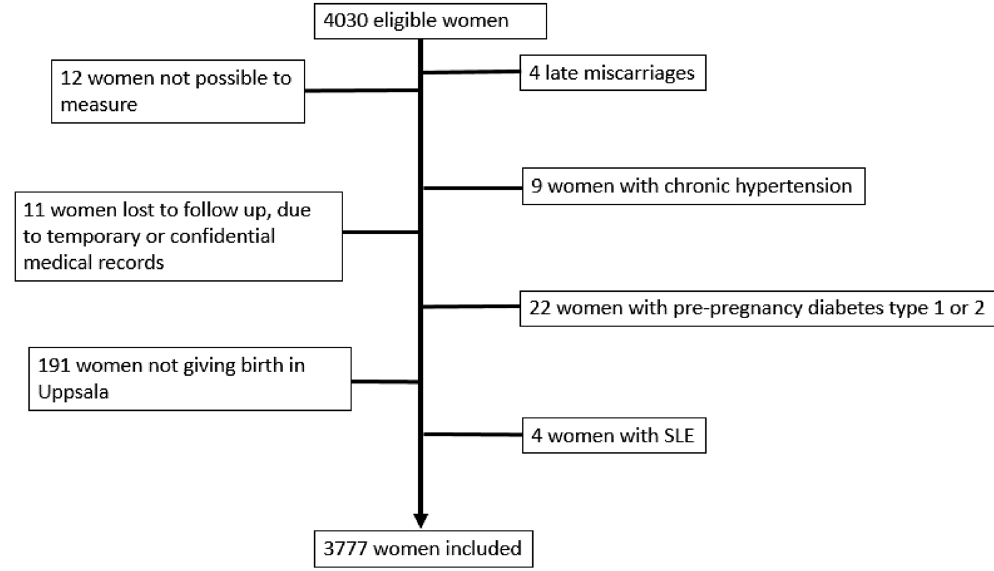
Figure 1. Flow chart of the study